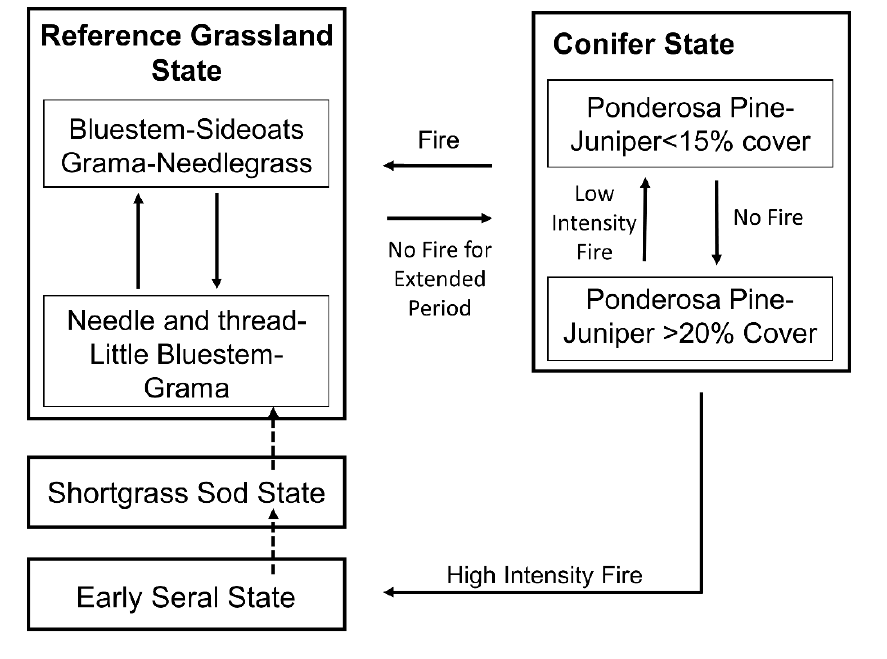
Figure A1.2. A simplified state-and-transition model (STM) from the USDA Ecological Site Descriptions for the ‘Shallow’ ecological site in the Mixed Sandy and Silty Tableland and Badlands Major Labe Resource Area following its update in 2019. The STM has been simplified to only highlight the role of fire. Bold outlined boxes denote alternative ecological regimes (also termed states). Continuous arrows represent a transition between ecosystem states (bold boxes) or community phases (light boxes). Dotted arrows represent where recovery may not be fast. Words next to arrows represent where fire is a proposed driver of